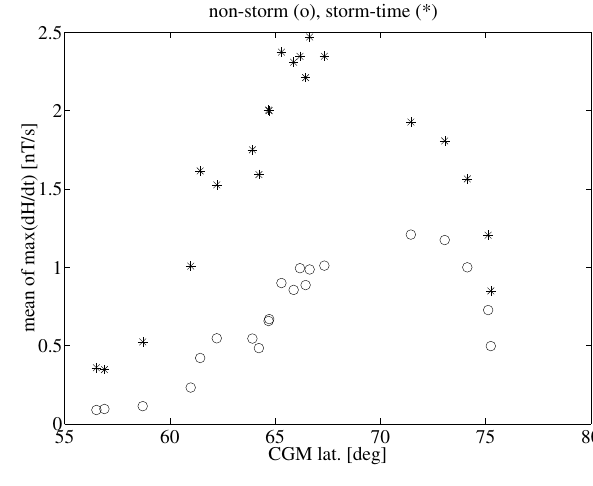
Fig. 2. Average of max( | d H /dt | ) during substorms as a function of Fig. 1. Diurnal variation of the number of observations in 1999– the CGM latitude. Circles: non-storm substorms, asterisks: storm- 2000 when the absolute value of GIC (10-s data) exceeded 2.5A H /dt j ) during substorms as a function of the CGM latitude. variation of the number of observations in 1999-2000 when the absolute Fig. 1. Diurnal Fig. 2. Average of max( j d time at the Pirttikoski 400-kV transformer in northern Finland. The cor- rected geomagnetic (CGM) latitude of this site is about 63degN. value of GIC (10 s data) exceeded 2.5 A at the Pirttikoski 400 kV transformer in northern Circles: non-storm substorms, asterisks: storm-time substorms. The figure is taken from Viljanen et al. (2001). Finland. The corrected geomagnetic (CGM) latitude of this site is about 63 deg N. The